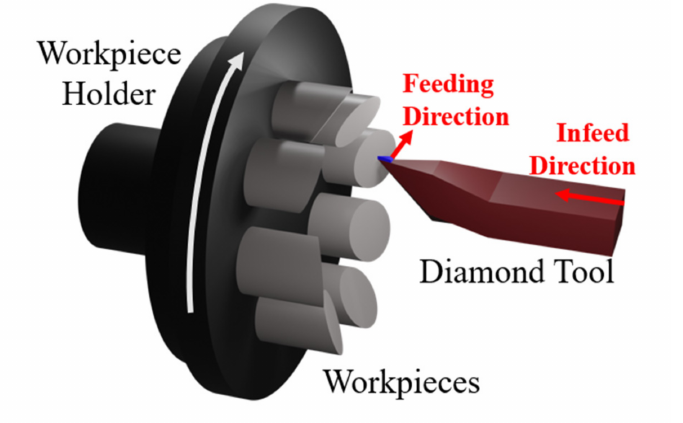
Figure 6. Layout of multiple optics in a Single Diamond Turning Operation. Pictured is a set of off-axis parabolas; similar technique can be employed for flats.